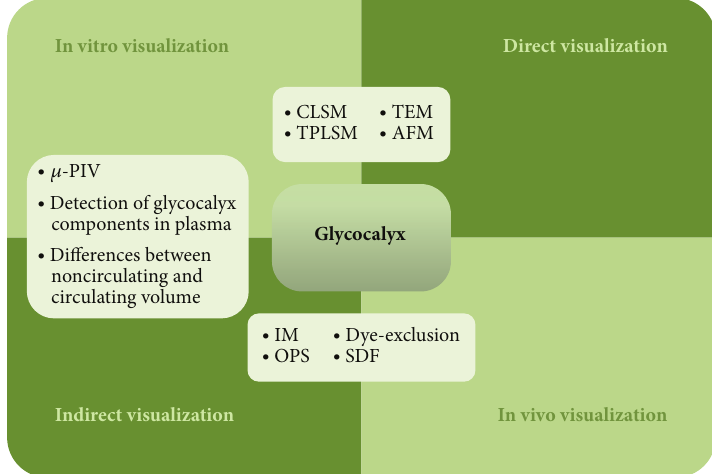
Figure 2: Summary of methods which are currently used in direct or indirect visualization of glycocalyx in vivo and in vitro . Confocal laser scanning microscopy (CLSM), two-photon laser scanning microscopy (TPLSM), transmission electron microscopy (TEM), atomic force microscopy (AFM), intravital microscopy (IM), microparticle image velocimetry ( 𝜇 -PIV), orthogonal polarization spectral imaging (OPS), and side-stream dark field imaging